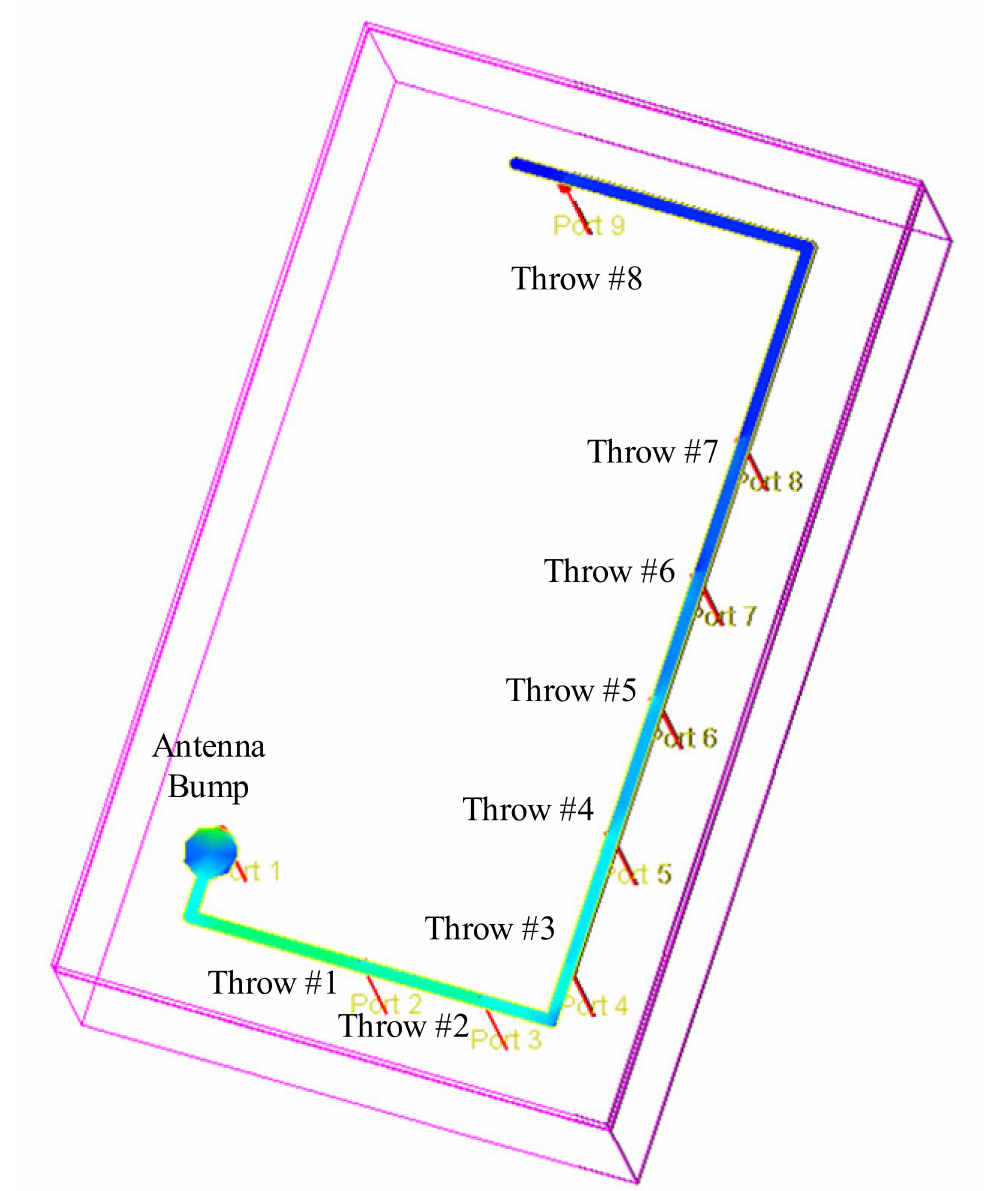
Figure 4. Electromagnetic analysis over the conventional direct antenna